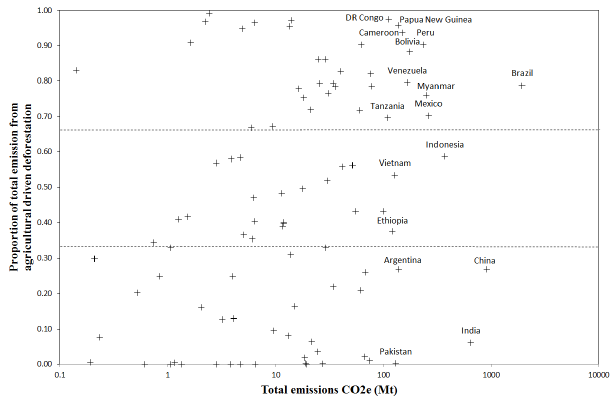
Figure 4. Total CO 2 emissions (annual AGB and BGB removals on forest land converted to agriculture (2000–2010/12) plus annual agricultural emissions, 2010), and the proportion of the total emis- sions from agricultural-driven deforestation (1 = 100% emissions from agricultural-driven deforestation, 0 = 100% emissions from agriculture). The 17 countries with emissions >100Mt are labelled ( n = 95). The horizontal lines distinguish the groups where total emissions are >66 % from agriculture (lower third), 33–66 % from agriculture-driven deforestation and agriculture (middle third) and >66 % (middle third) from agriculture-driven